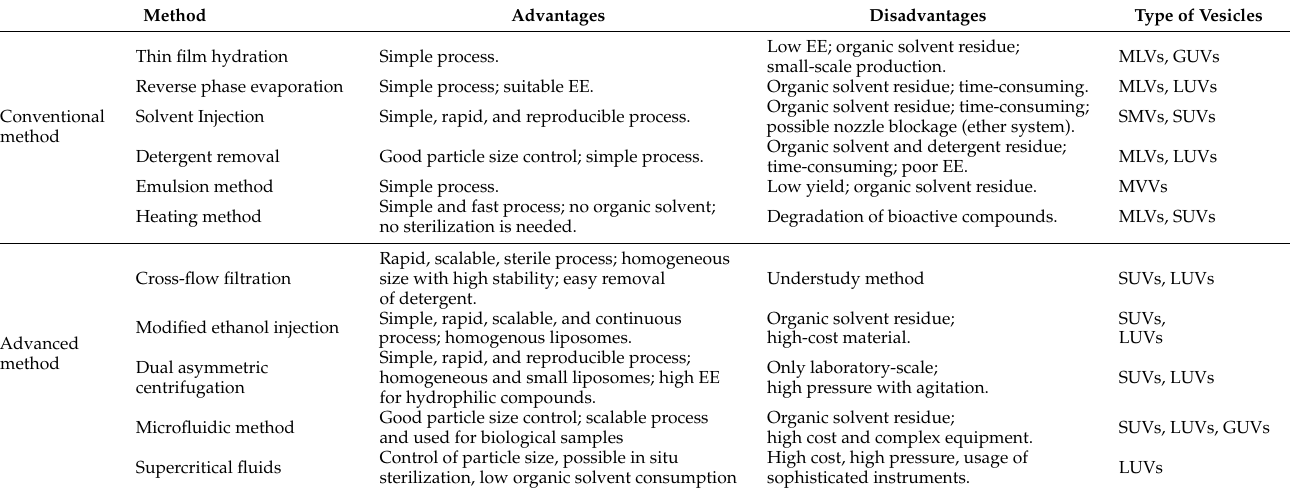
Table 1. Methods of liposomes preparation